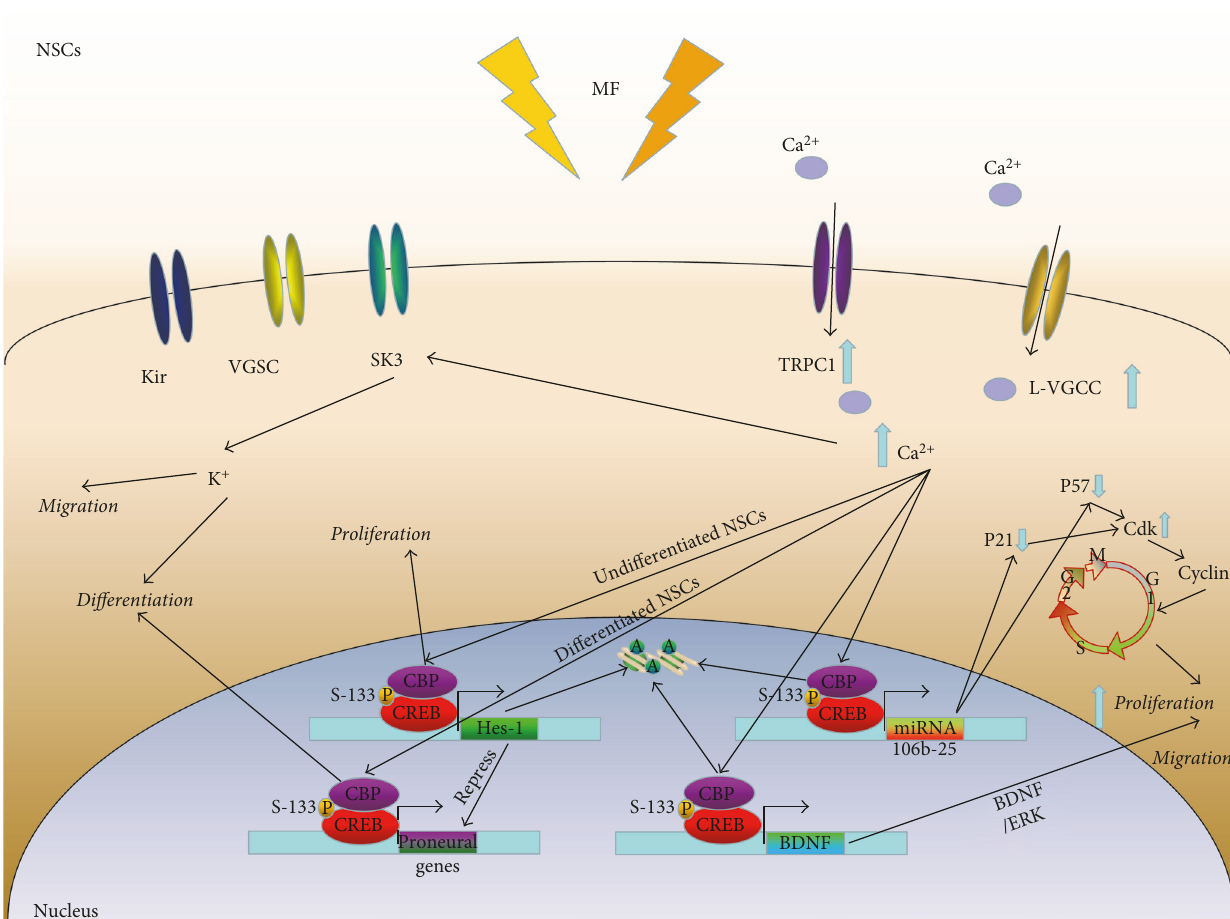
Figure 2: Potential mechanisms of electromagnetic fi eld regulation on neural stem cells. Ca 2+ and CREB might be the hinge of e ff ects, because of a lack of excitability of NSCs, and according to the Faraday e ff ects, a possible mechanism could be that the MFs facilitate the exchange of intracellular and extracellular ions through these long-term opened ion channels and upregulate the expression of voltage-gated Ca 2+ channels (VGCCs) or TRPC1 result in a current and potential di ff erence of NSCs, Ca 2+ fl ood into from extracellular matrix or endoplasmic reticulum through the voltage-dependent channel or the force of MF itself; on the one hand, intracellular Ca 2+